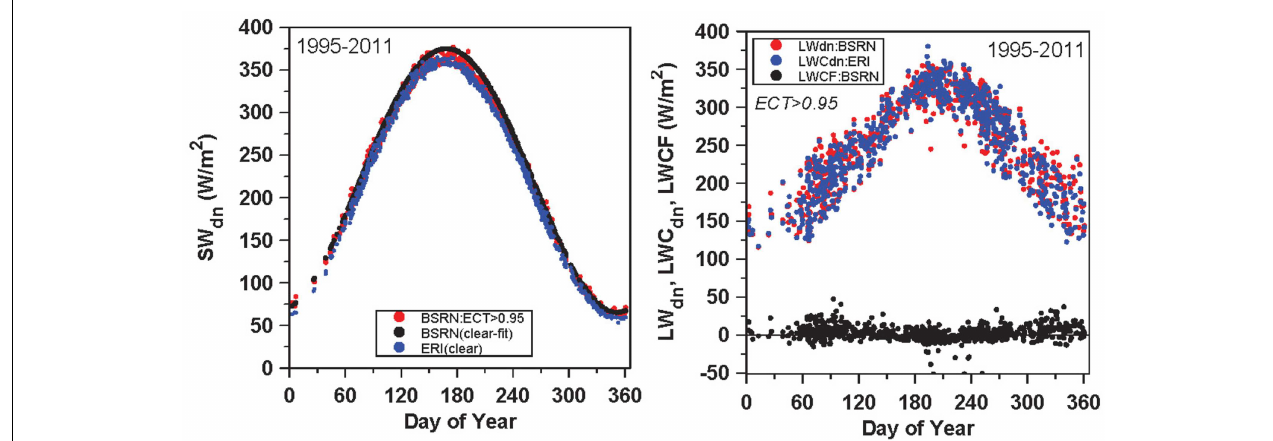
FIGURE 2 | Clear sky (ECT > 0.95) BSRN SW dn , ERA-Interim SWC dn and clear-sky fit used with BSRN data (left) and (right) BSRN LW dn , ERA-Interim LWC dn and the difference, the